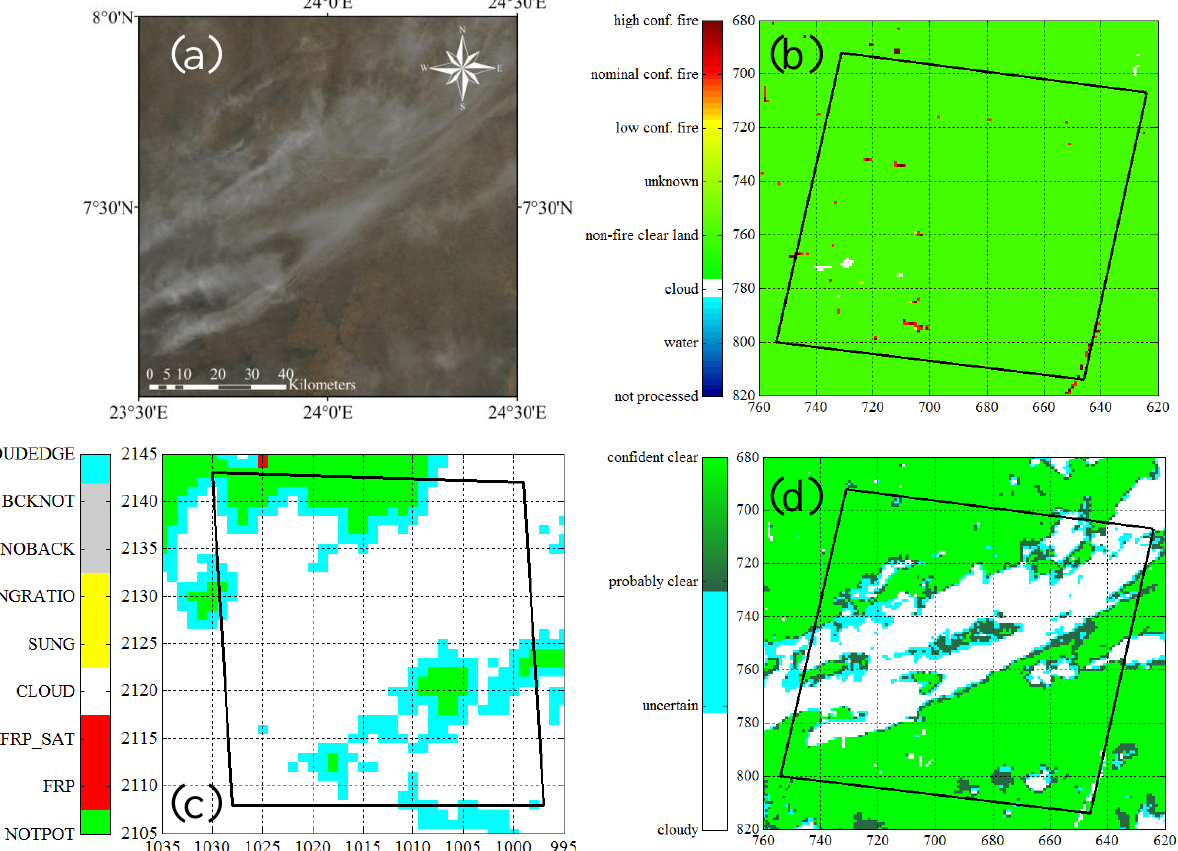
Figure 7. Simultaneous comparisons between the cloud masks used in the MODIS and SEVIRI active fire products at 12:00 UTC on 11 January 2009 within ROI 1 (Figure